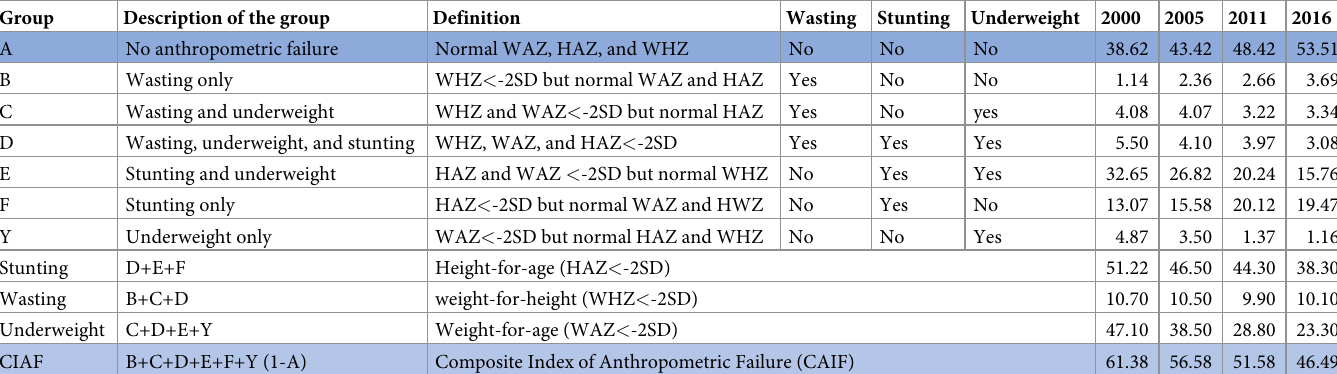
Table 1. Classification of undernourished under-five children and their percentages over time in Ethiopia.